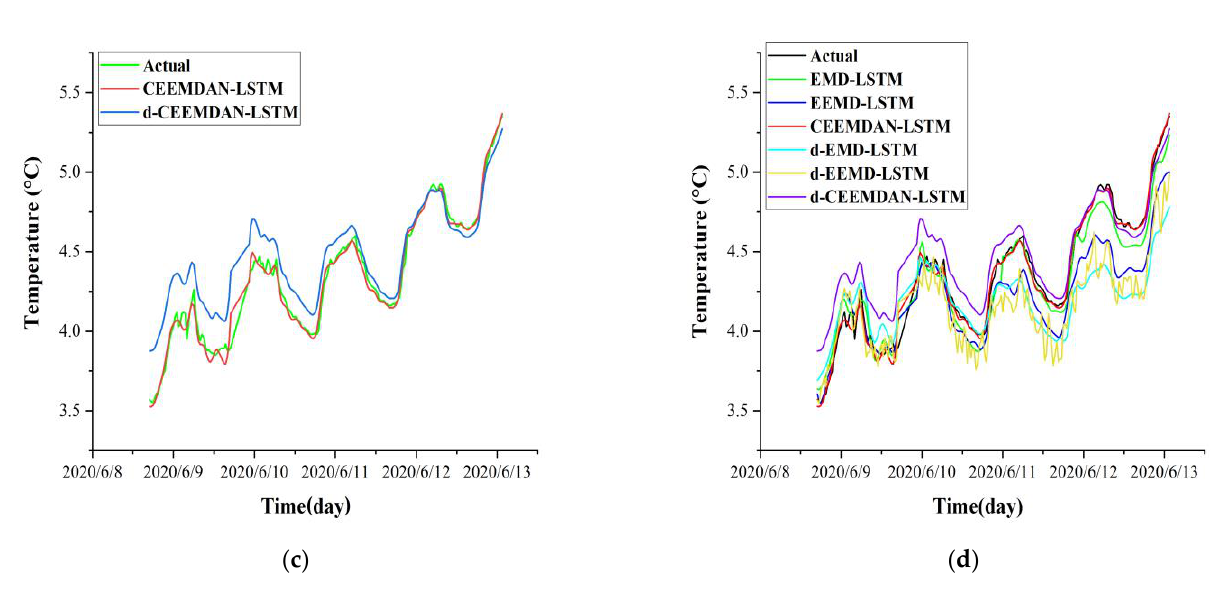
Figure 10. Comparison of prediction results of models with single dataset and hybrid dataset. ( a ) EMD-LSTM model (input hybrid dataset) versus d-EMD-LSTM model (input single dataset); ( b ) EEMD-LSTM model (input hybrid dataset) versus d-EMD-LSTM model (input single dataset); ( c ) CEEMDAN-LSTM model (input hybrid dataset) versus d-EMD-LSTM model (input single dataset); ( d ) Comparison of prediction results of all models.